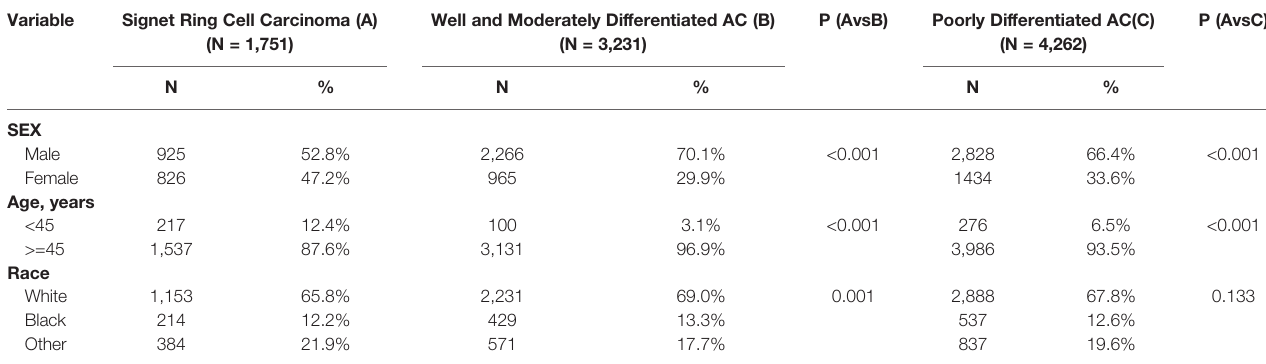
TABLE 1 | Demographic characteristics of study